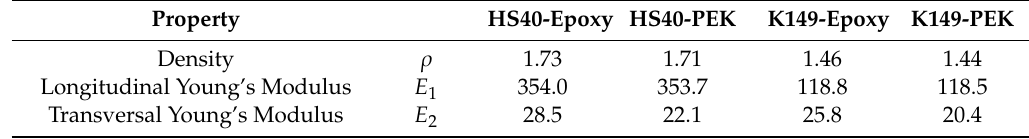
Table 3. Orthotropic mechanical properties and density of the designed